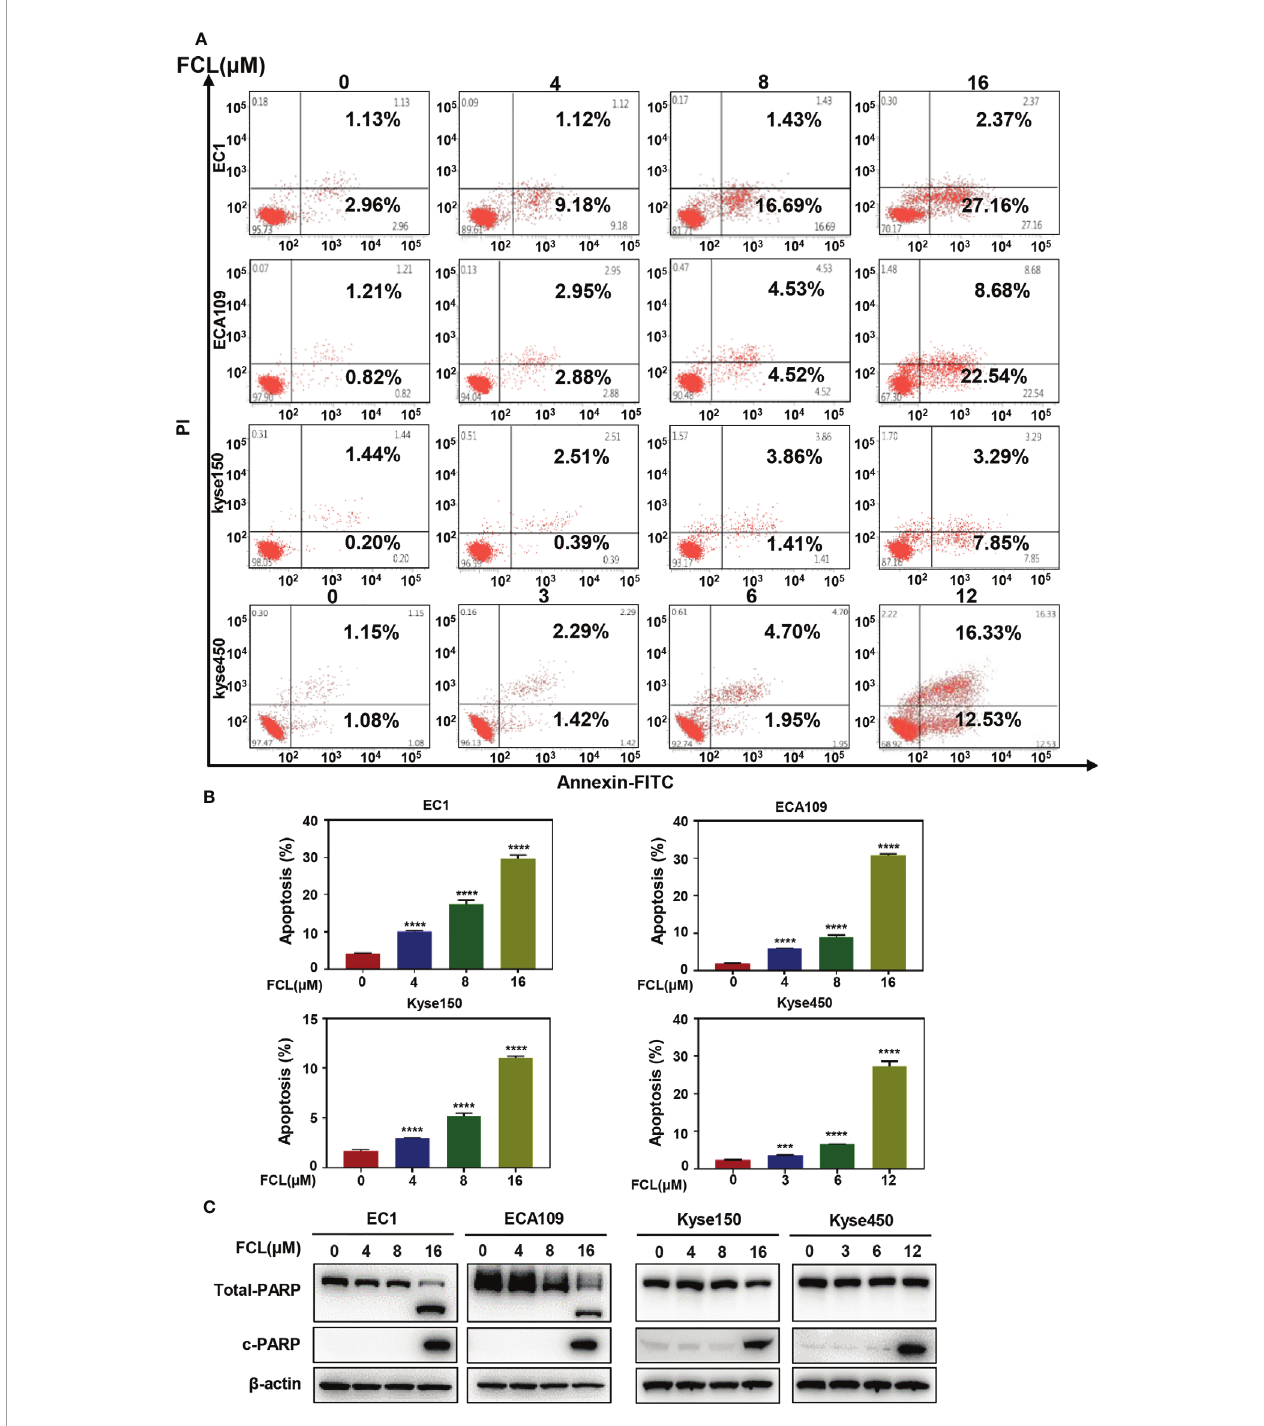
FIGURE 3 | Fangchinoline induced apoptosis in ESCC cells. (A, B) ESCC cells were pre-incubated with the indicated concentrations of FCL or DMSO for 24 hours, and then the cells were detected with an annexin-V-FITC apoptosis detection kit and analyzed with FCAS. (C) FCL increased the proteins level of c-PARP. ESCC cells were treated at the indicated concentrations of FCL or DMSO for 24 hours, and cell lysates were analyzed by Western blotting with an antibody against c-PARP. ***denotes P < 0.001, ****denotes P <